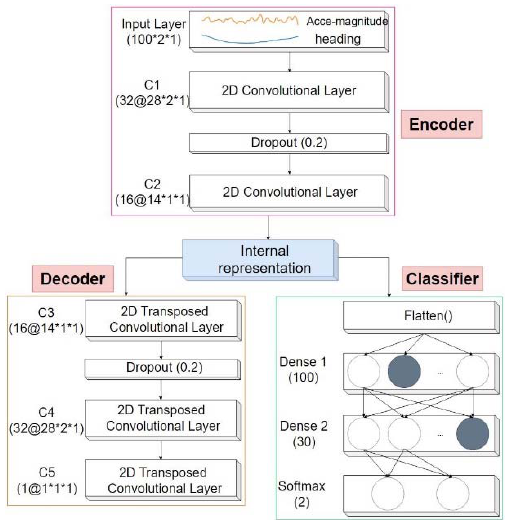
Table 7. Recognition performance of door opening.